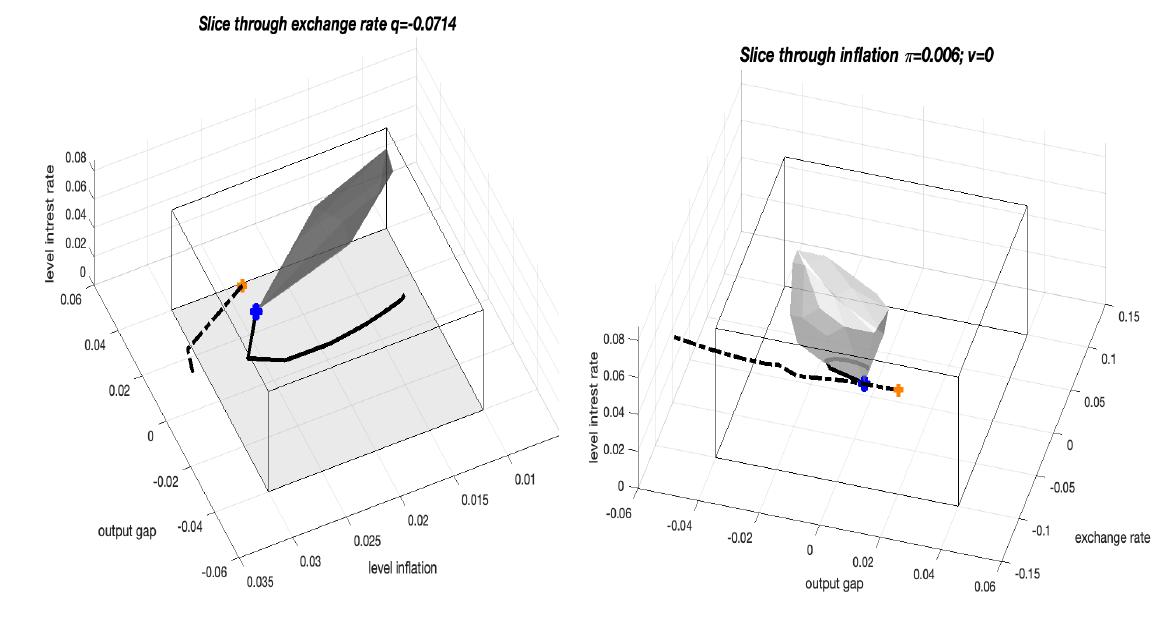
Figure 4. Economy evolutions shown in 3D